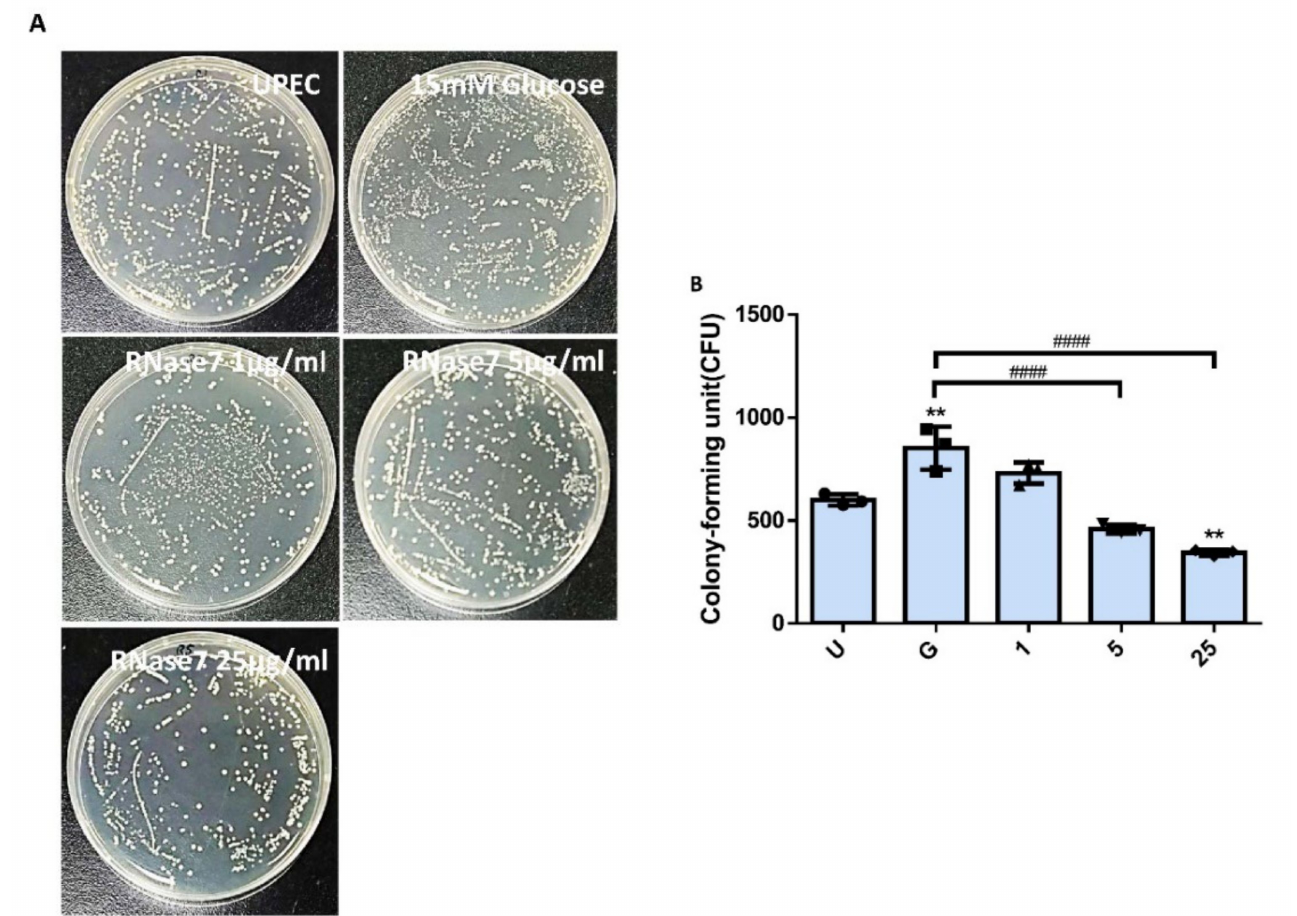
Figure 1. Influence of RNase 7 on UPEC infection in bladder cells in a high-glucose environment. SV-HUC-1 cells were pretreated with different concentrations of RNase 7 (1, 5, and 25 µ g/mL) and 15 mM glucose for 24 h and then infected with pGFP-UPEC (MOI:1:100) as described in the text. UPEC infection in bladder cells was examined by plating on LB agar ( A ) and determined using ImageJ software ( B ). Colony-forming units (CFUs) were acquired after plating out lysed solutions of infected cells. The definitions of each letter/number represented by the X axis are: U: UPEC infection alone; G: with 15 mM glucose pretreatment alone; 1, 5, and 25: pretreated with 1, 5, and 25 µ g/mL RNase 7, respectively, + 15 mM glucose. Data are expressed as the mean ± SD of three independent experiments. ** p < 0.01, compared to UPEC infection control groups. #### p < 0.0001, compared between the two